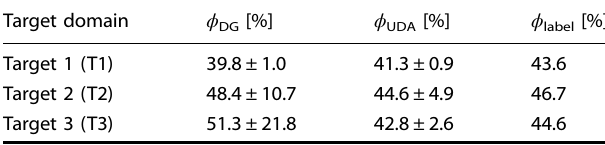
Table 5. Estimated phase fractions on the test sets of the different target domains with DG and UDA models.